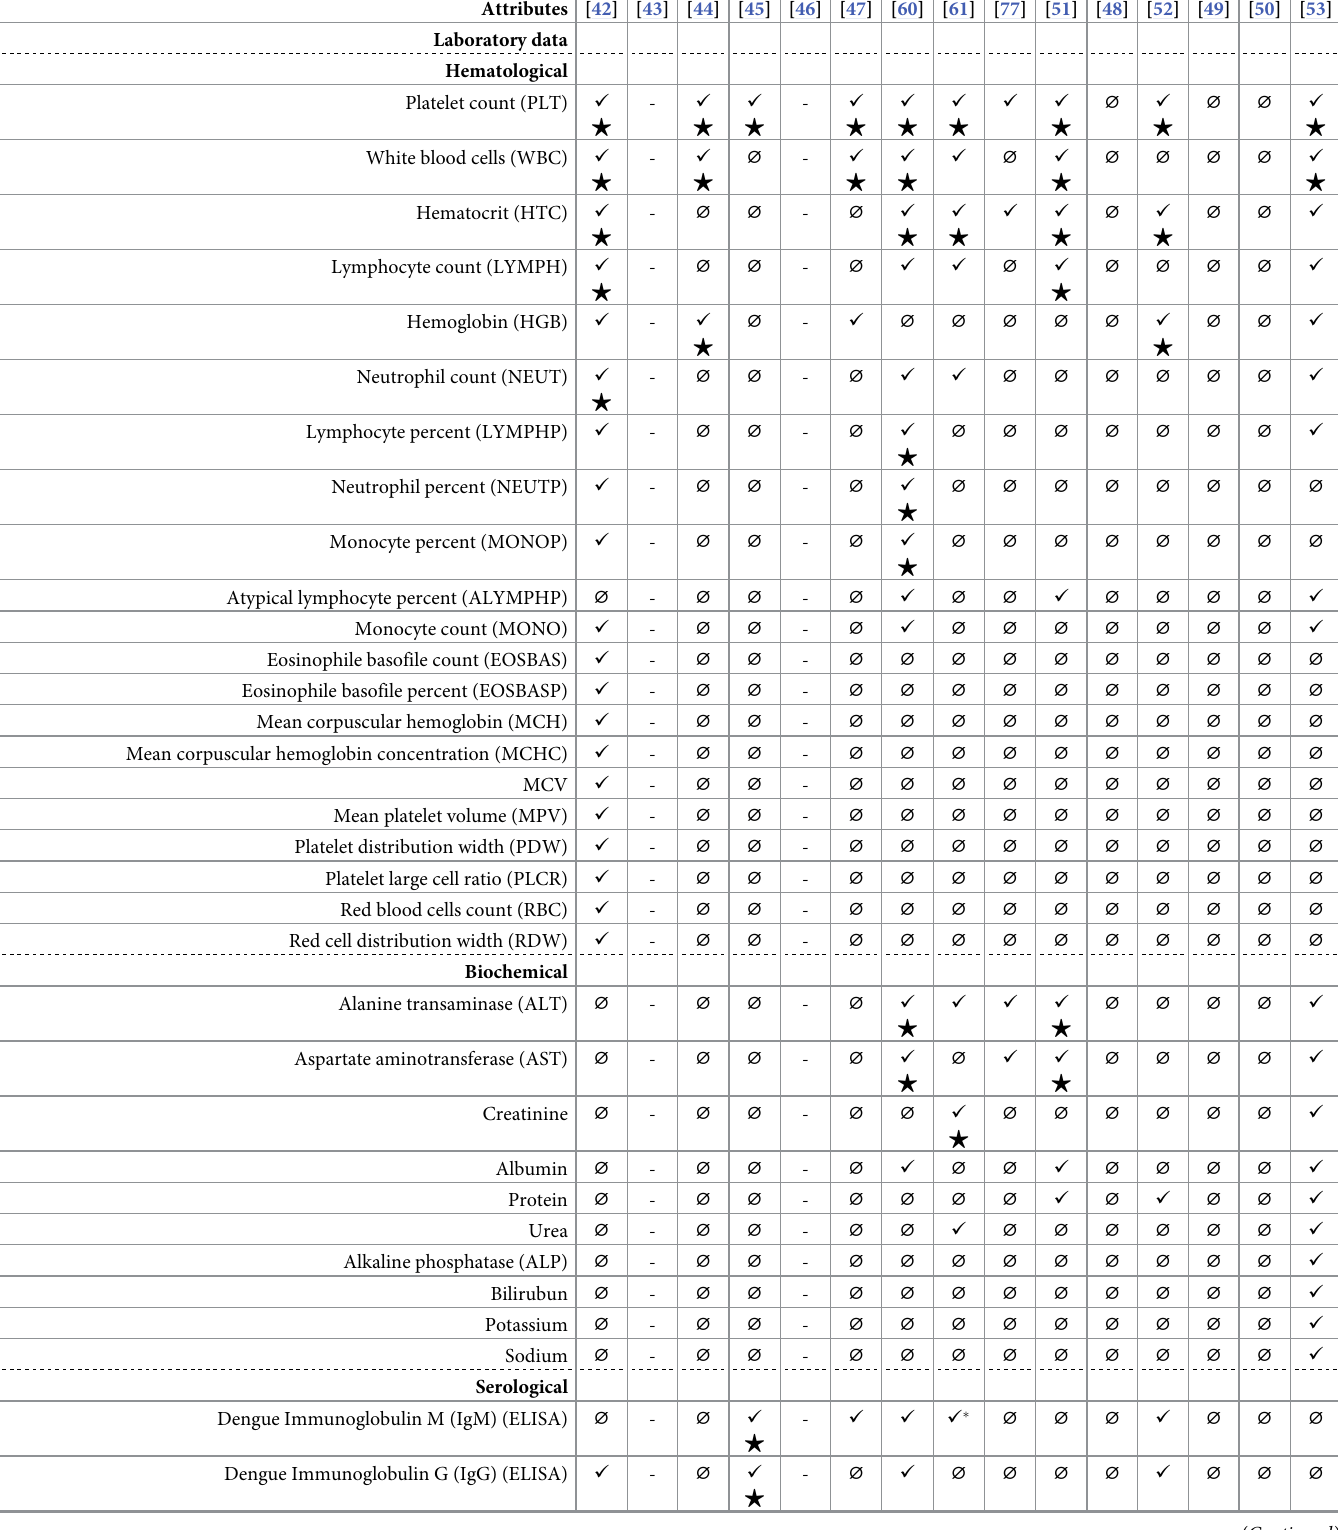
Table 5. Summary of all non-clinical data (laboratory and others) presented in the data set used by the primary